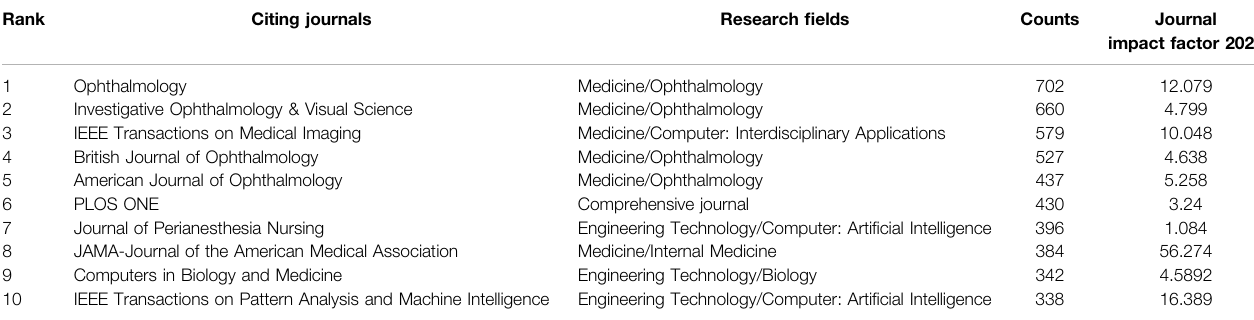
TABLE 4 | Top 10 cited journals of publications on the use of AI in the diagnosis of ophthalmic diseases from 2012 to